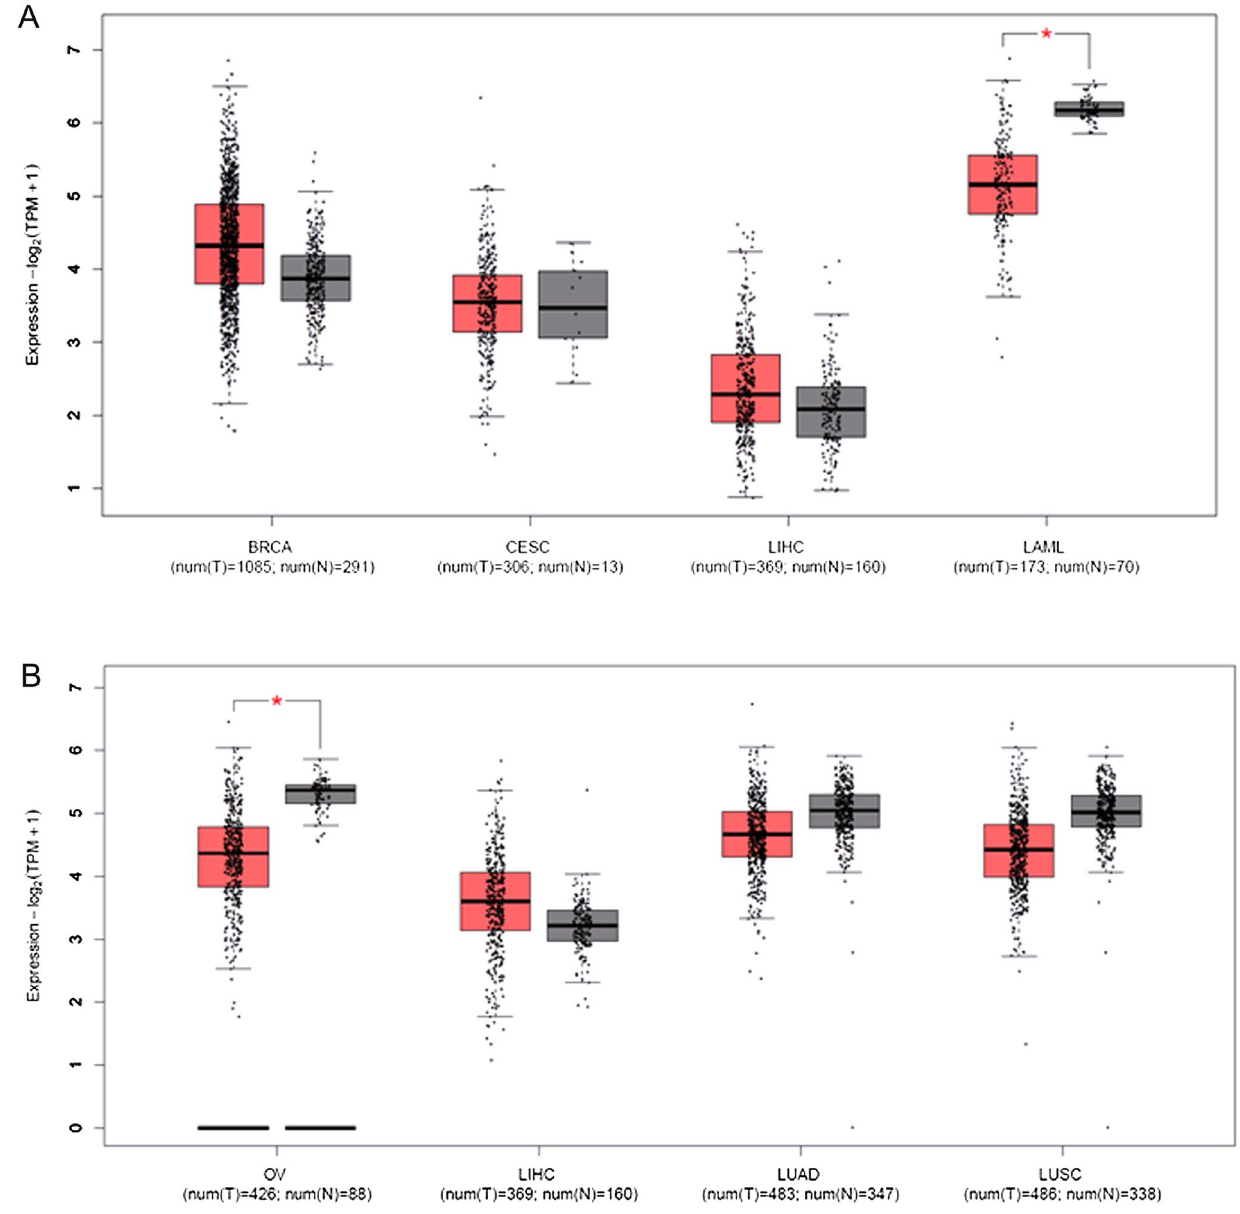
Fig. 1 Original version of Figure